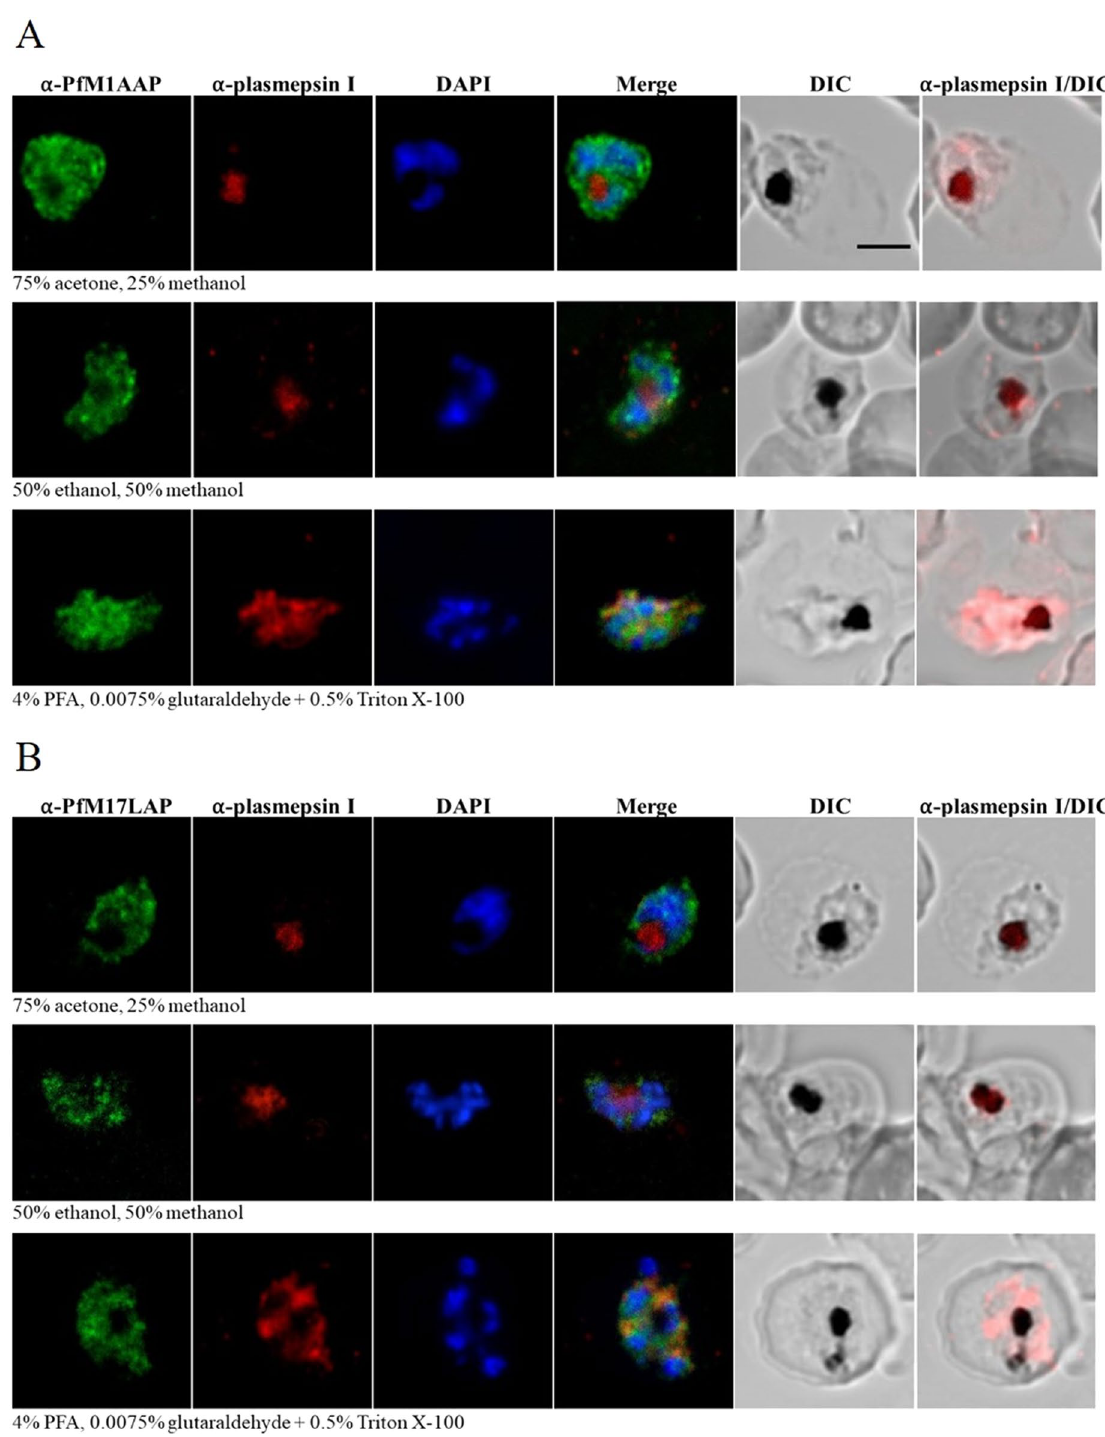
Figure 5. Localization of Pf M1AAP and Pf M17LAP in intra-erythrocytic P. falciparum 3D7 schizont-stage parasites. Immunofluorescence assays were carried out using air-dried blood smears fixed with 75% acetone and 25% methanol at − 20 °C for 5 min or 50% ethanol and 50% methanol at − 20 °C for 2 min or 4% PFA and 0.0075% glutaraldehyde for 20 min at room temperature. Fixed parasites were probed with polyclonal antibodies against ( A ) Pf M1AAP and ( B ) Pf M17LAP. Specific aminopeptidase staining (green, Alexa-Fluor 488) was observed in the cytosol of parasites. Parasite nuclei were visualized using DAPI (blue; 4,6-diamidino- 2-phenylindole) and monoclonal antibodies against the DV marker plasmepsin I (α-plasmepsin I, red, Alexa- Fluor 594) were used as a control. Differential interference contrast (DIC) and α-plasmepsin I with DIC are shown for reference. Scale bar, 3